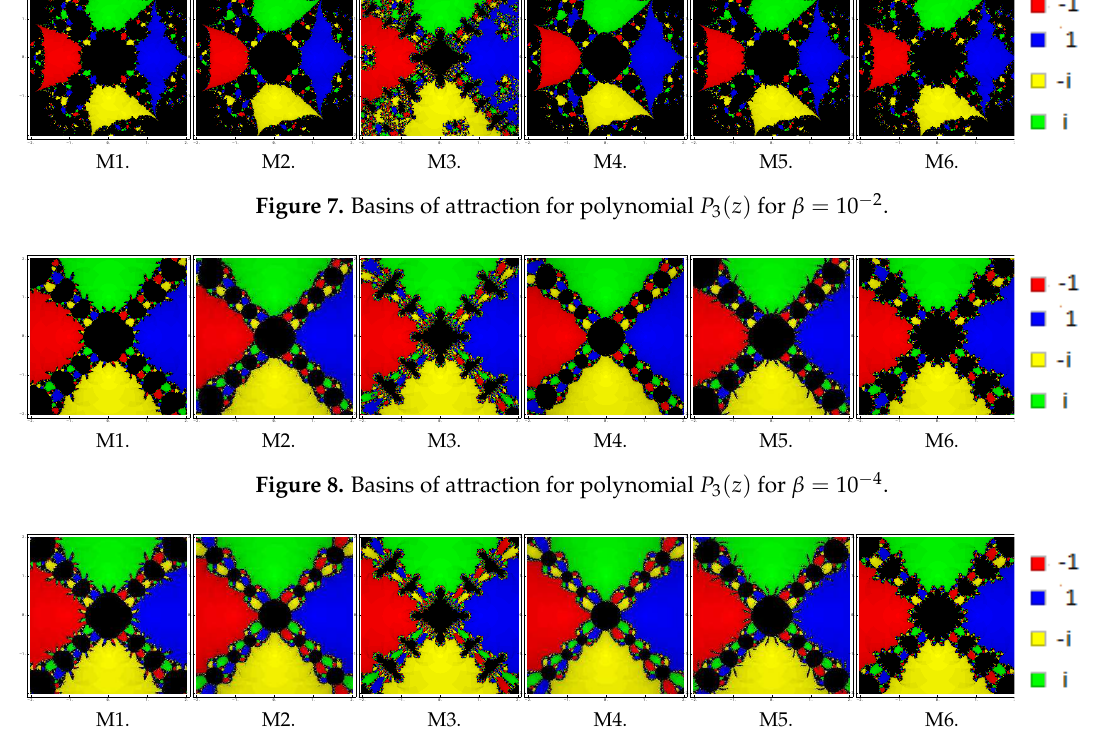
Figure 9. Basins of attraction for polynomial P 3 ( z ) for β = 10 − 6